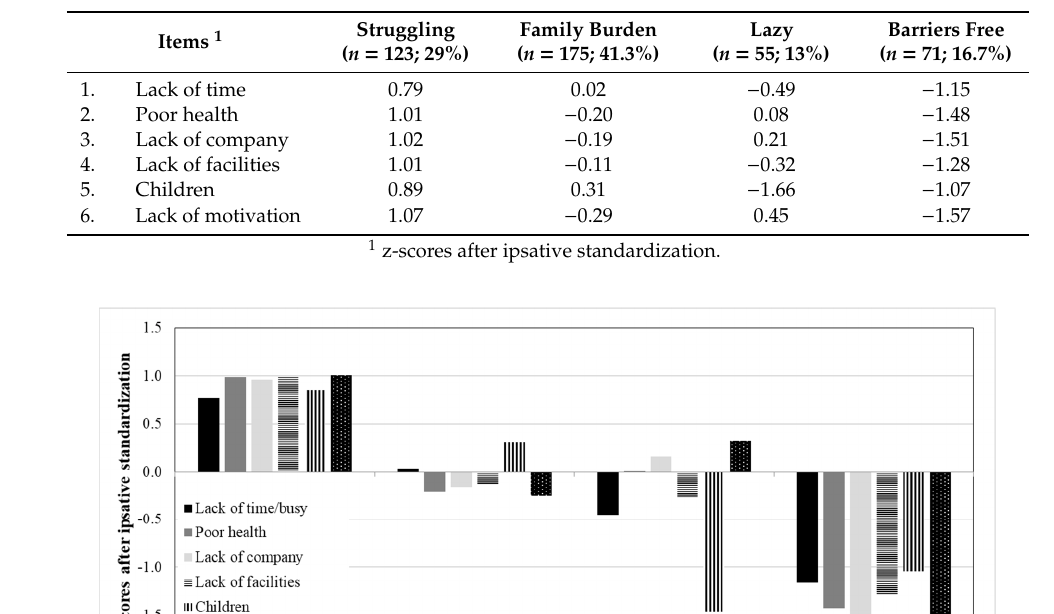
Table 3. Descriptive statistics on the 5 latent profile solution ( n = 424).